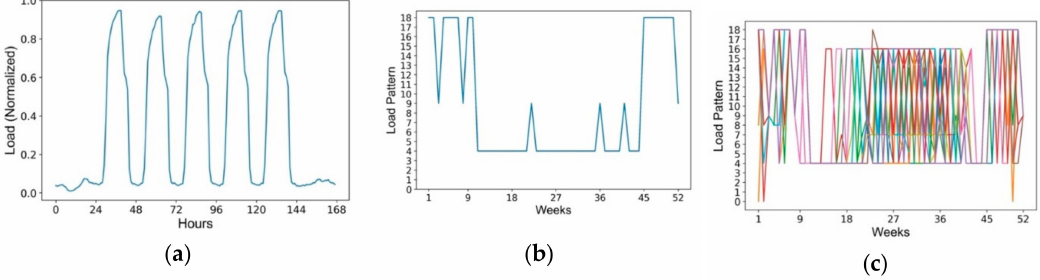
Figure 13. Typical user behaviors of Primary School ( b ), Secondary School ( c ) and corresponding load patterns in short-term ( a